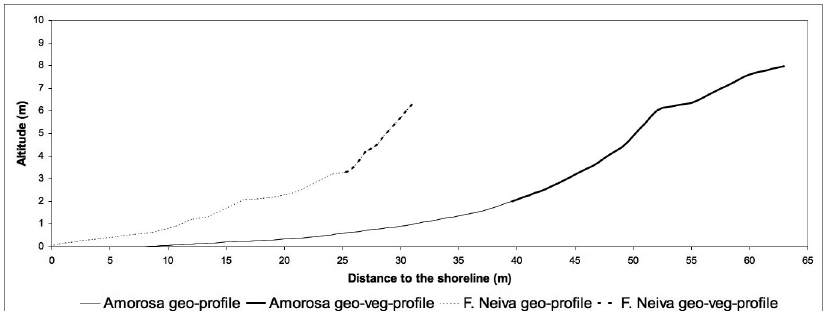
Figure 2. Indicative topographic profiles of sites with transgressive (F. Neiva, dashed lines) and (meta-) stable (Amorosa, solid lines) dynamics. Thick lines indicate the extension of vegetated profiles, from which all data used in statistical analyses were